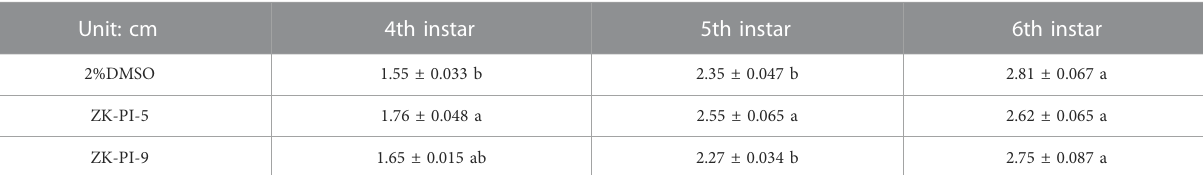
TABLE 3 Length of S. frugiperda